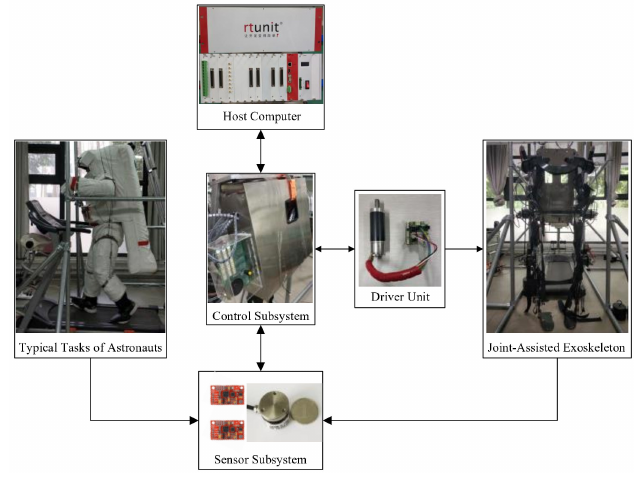
Figure 8. The exoskeleton experimental platform.